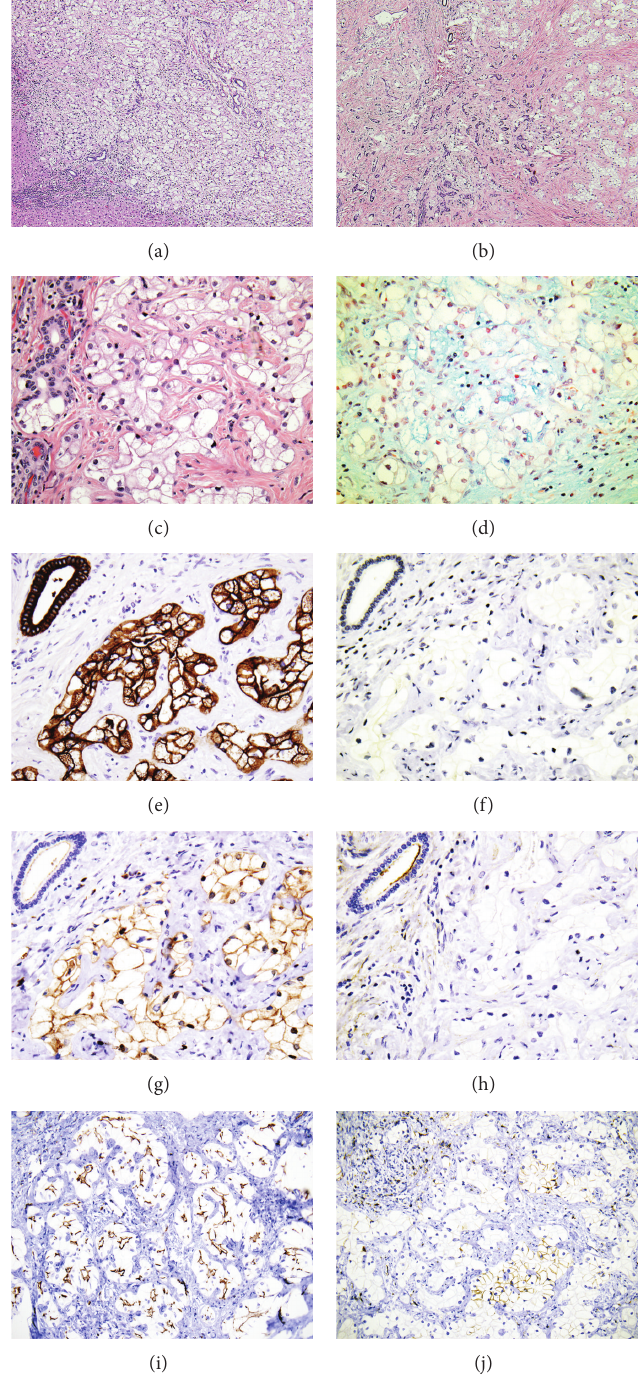
Figure 2: Microscopic and immunohistochemical features of intrahepatic clear cell bile duct adenoma. (a) Hematoxylin-eosin stained low power view showing tumor composed almost exclusively of clear cells with entrapped bile ducts and surrounding liver parenchyma. (b) Stromal fibrosis and partial replacement of normal bile duct cells by clear cells. (c) The tumor cells have abundant clear cytoplasm and round to oval hyperchromatic nuclei with inconspicuous nucleoli. (d) The clear cells are focally positive for Alcian blue staining. (e–h) Immunohistochemical staining of clear cells demonstrates activity for CK7 (e) and polyclonal CEA (g) but negative staining for CK20 (f) and EMA (h). (g-h) Clear tumor cells demonstrated continuous apical staining for CD10 (g) and focal membraneous staining for CD56 (h) (a-b, × 100; c–h, × 400; i-j, ×